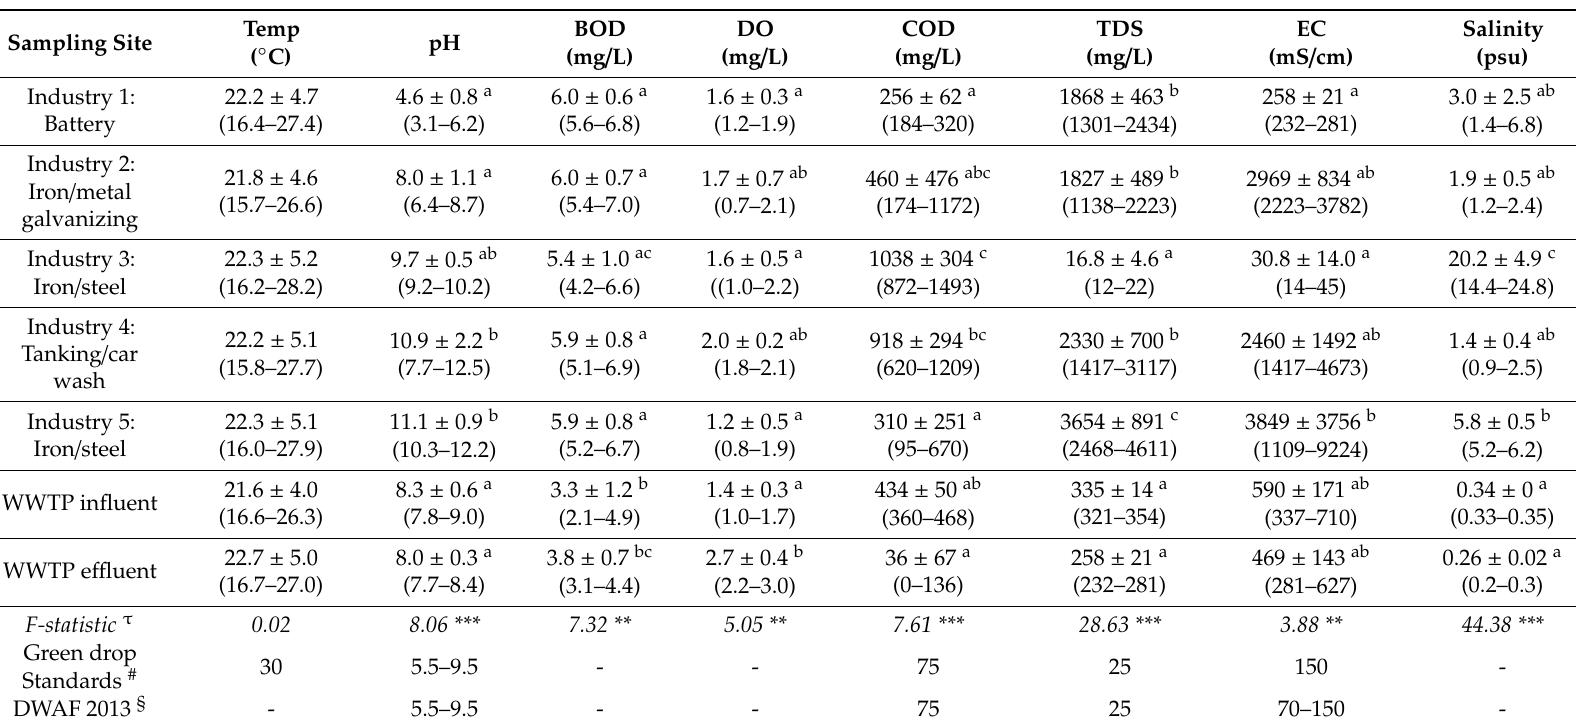
Table 1. Summary of physicochemical characteristics (mg / L) in the di ff erent industrial wastewater and Leeuwkuil WWTP e ffl uents of the Vaal triangle η